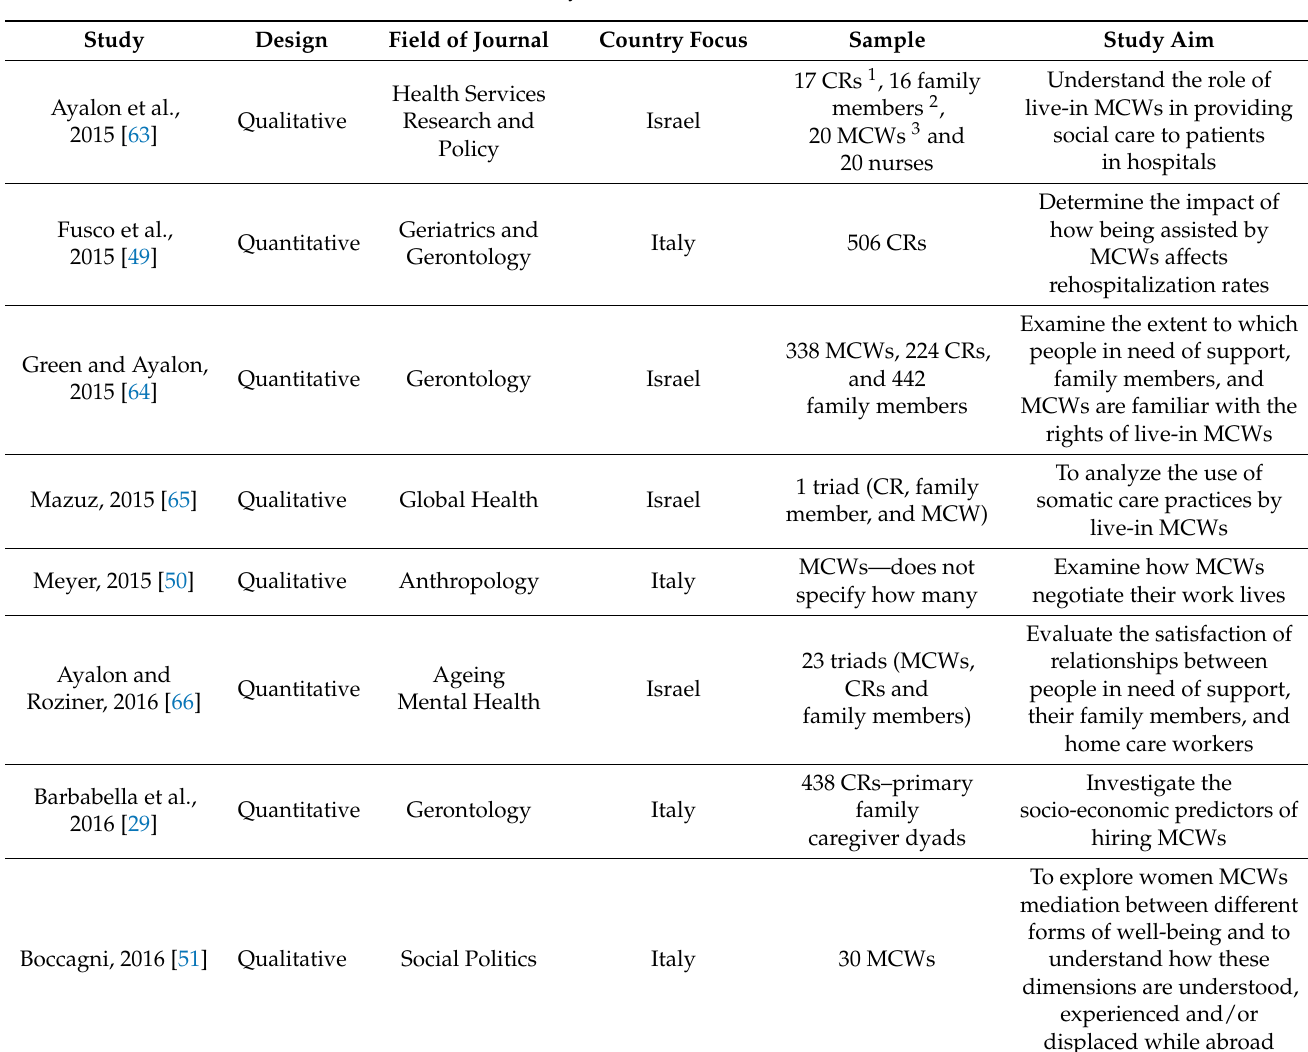
Table 1. Summary of articles included in this